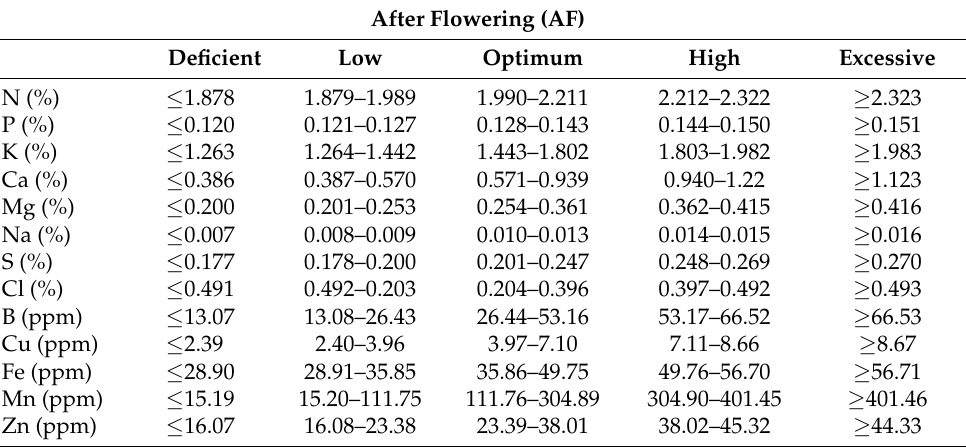
Table 4. Nutrient optimal range (NOR) in the AF stage of persimmon fruit in PDO ‘Kaki Ribera del X ú quer’,